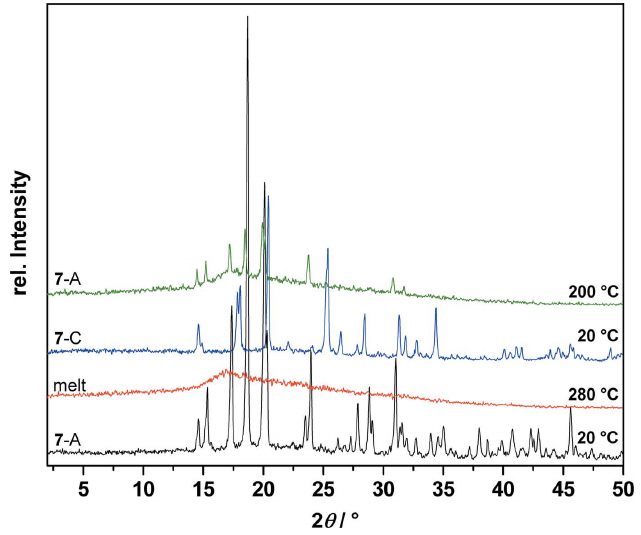
Figure 20 Temperature-dependent X-ray powder diffraction traces of myo -inositol ( 7 ) at 20 up to 280 down to 20 and up to 200 (cid:2) C showing the melt of polymorph 7 -A (black and red), recrystallization to 7 -C (blue) and phase transition back to 7 -A (green).